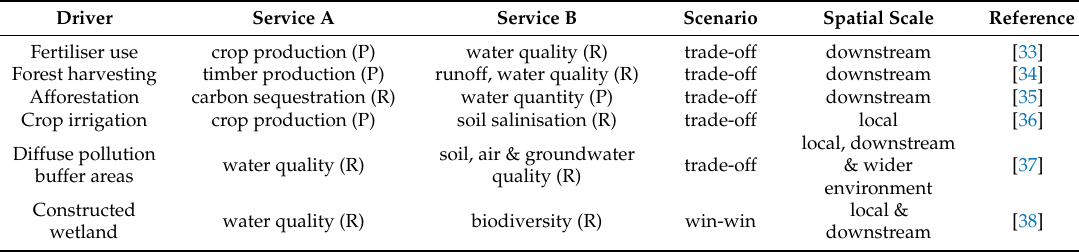
Table 1. Examples of pair-wise trade-offs (negative interaction) and win-win (positive interaction) relationships between provisioning (P) and regulating (R) ecosystem services. Impacts may be expressed either locally, downstream, or in the wider